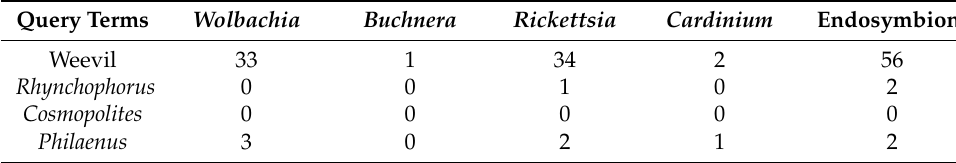
Table 1. Results of PubMed interrogations with query terms combinations 1